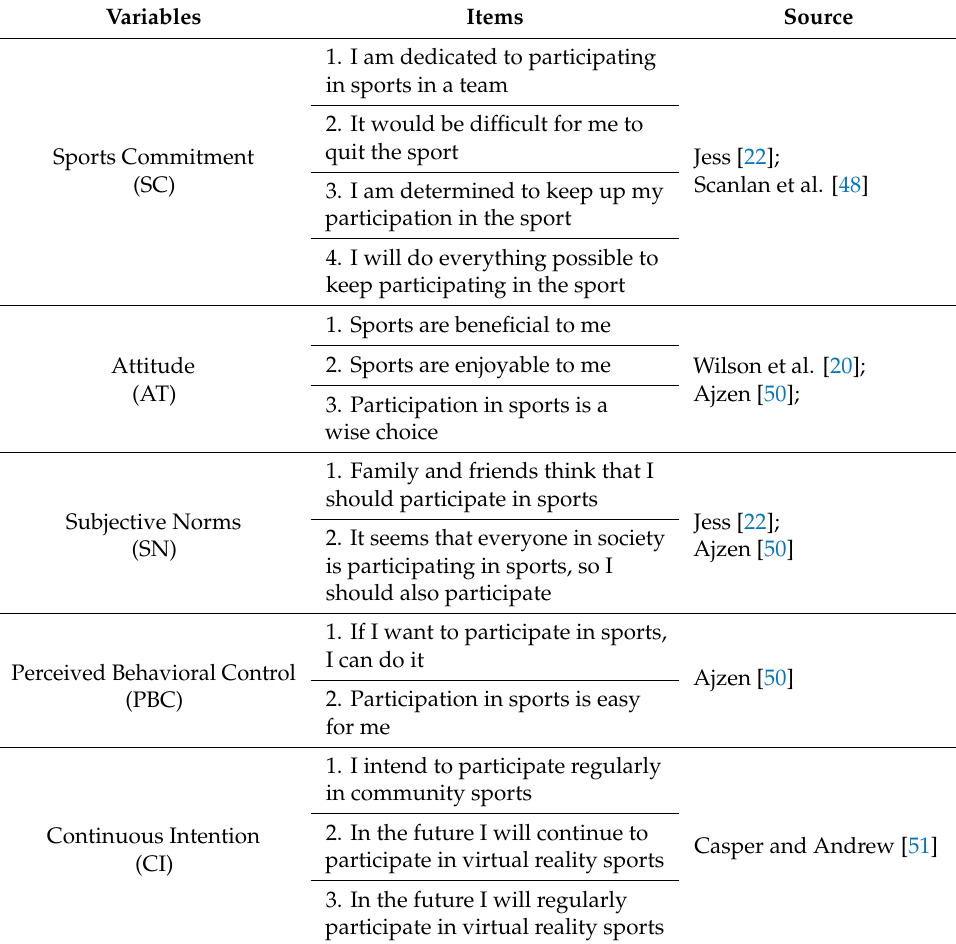
Table 1. Operational definitions of variables and